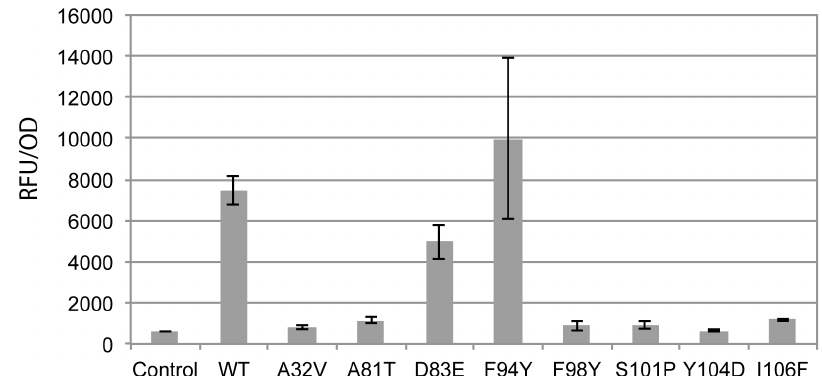
Figure 2. Ability of EsaR* variants to bind AHL invitro . Fluorescence output was measured from an E. coli MG1655 reporter strain harboring plasmid pJW0lS, which was exposed to AHL extracted from purified wild-type (WT) or EsaR* protein as indicated. Fluorescence values were standardized by dividing by the final OD 600 for each sample. The assays were performed as two independent triplicate sets.